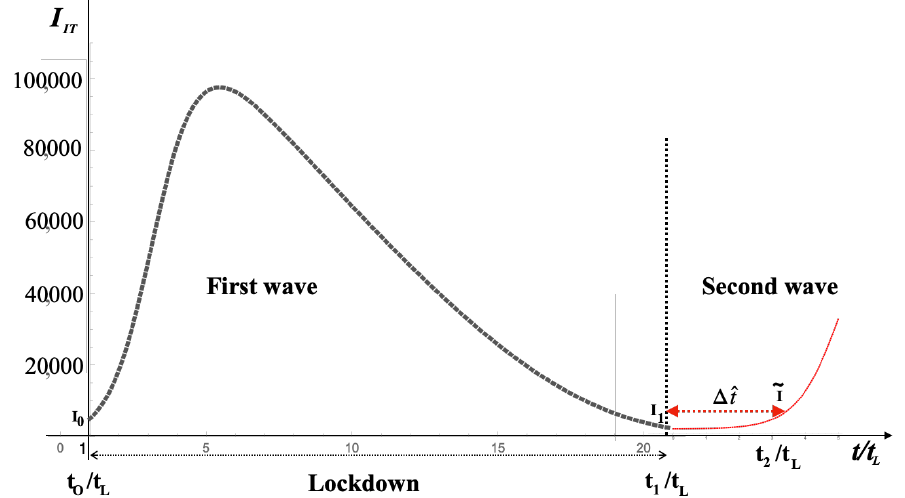
Figure 2. Schematic representation of the second wave of SARS-CoV-2 infection. The Lockdown measures are applied during the period ˆ t 0 − ˆ t 1 . At the end of the confinement measures, the number of infectious dropped to I 1 . During the time interval ∆ ˆ t = ˆ t 2 − ˆ t 1 , the lockdown measures are not applied and the infection by SARS-CoV-2 (starts growing again ( second wave of Coronavirus infection) until the preset value ˜ I is reached, which corresponds to I ( ˆ t 2 ) . During the whole time interval ∆ ˆ t , the number of infectious individuals still stay below a set threshold ˜ I if I 1 satisfies condition (25).